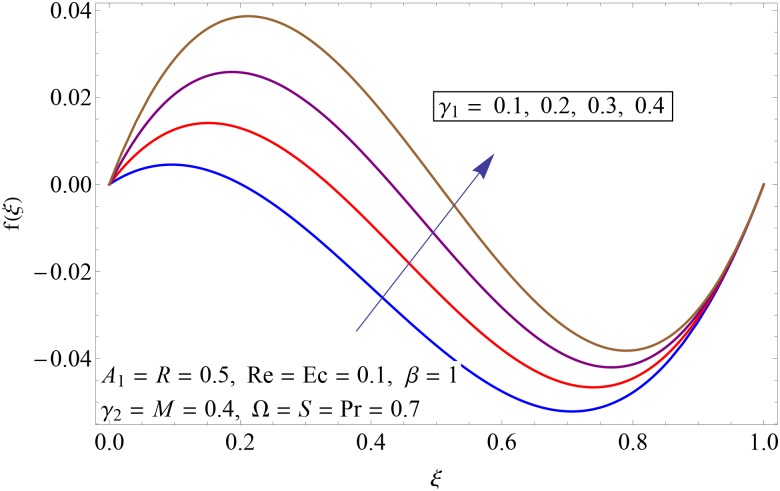
Impact of γ1 on f(ξ).